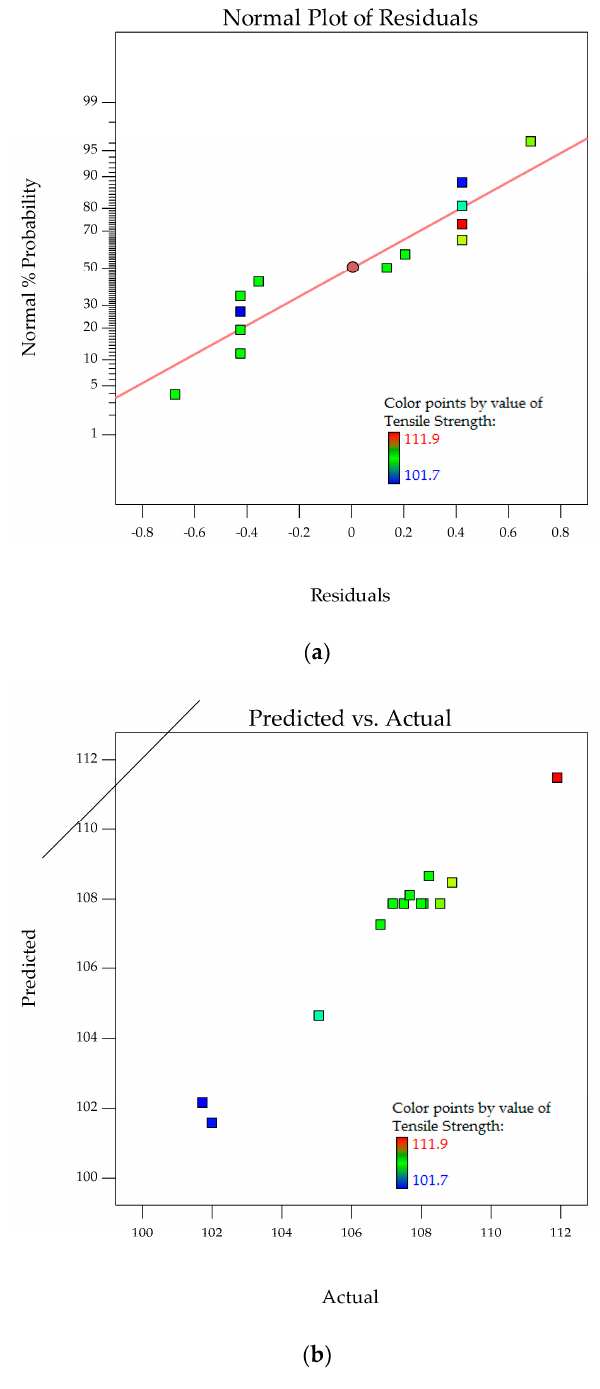
Figure 4. Stochastic error and deterministic portion for tensile strength of POM composites as ( a ) normal probability plot for residuals; ( b ) predicted versus actual values.